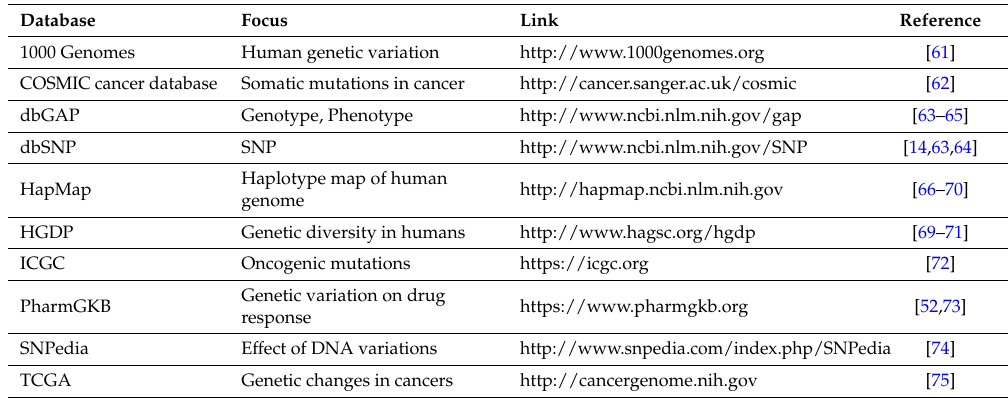
Table 4. Databases for SNP studies.